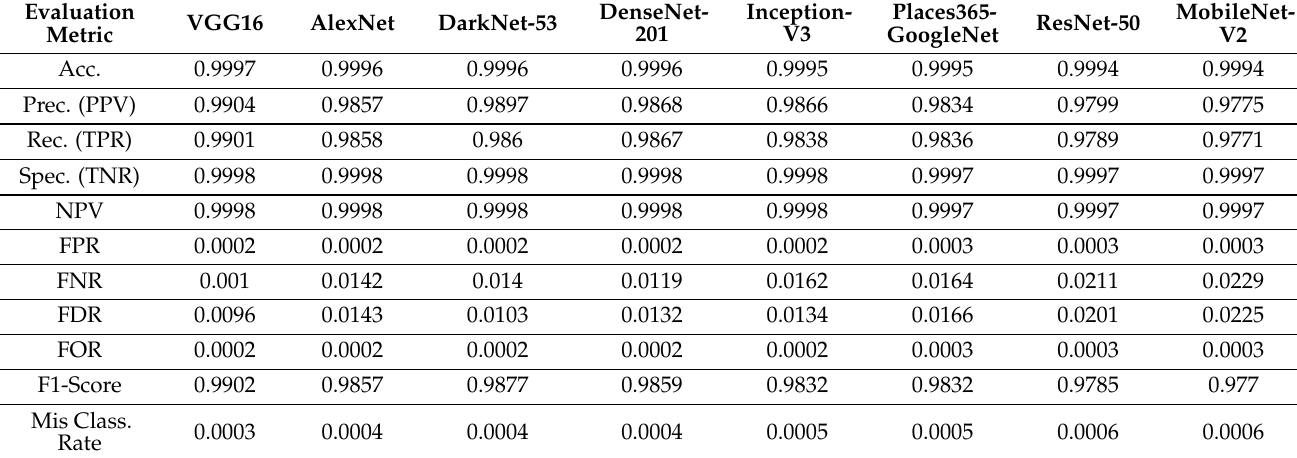
Table 7. Average values of the evaluation metrics of the eight examined fine-tuned CNN classification